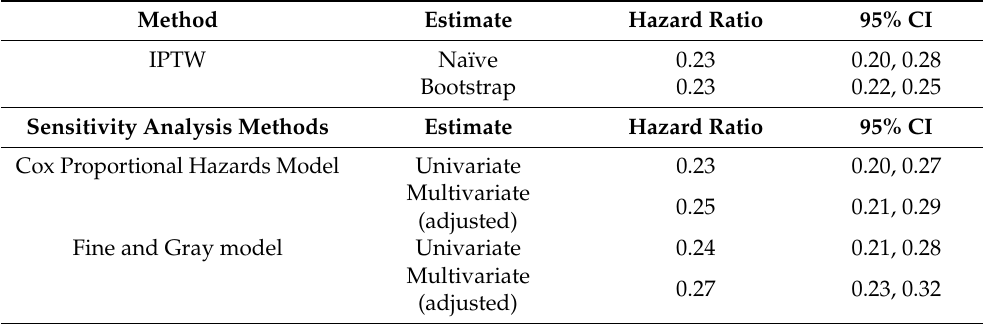
Table 7. Hazard ratios for cancer-related deaths in DART completers vs. non-completers.